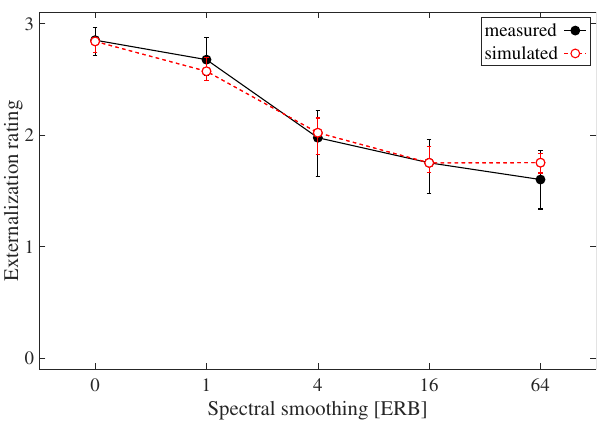
Figure 4. Averaged ILD across subjects with 0% (red solid line), 50% (blue dotted line) and 100% (green dashed line) compression factors. Shaded areas denote 95% CIs of